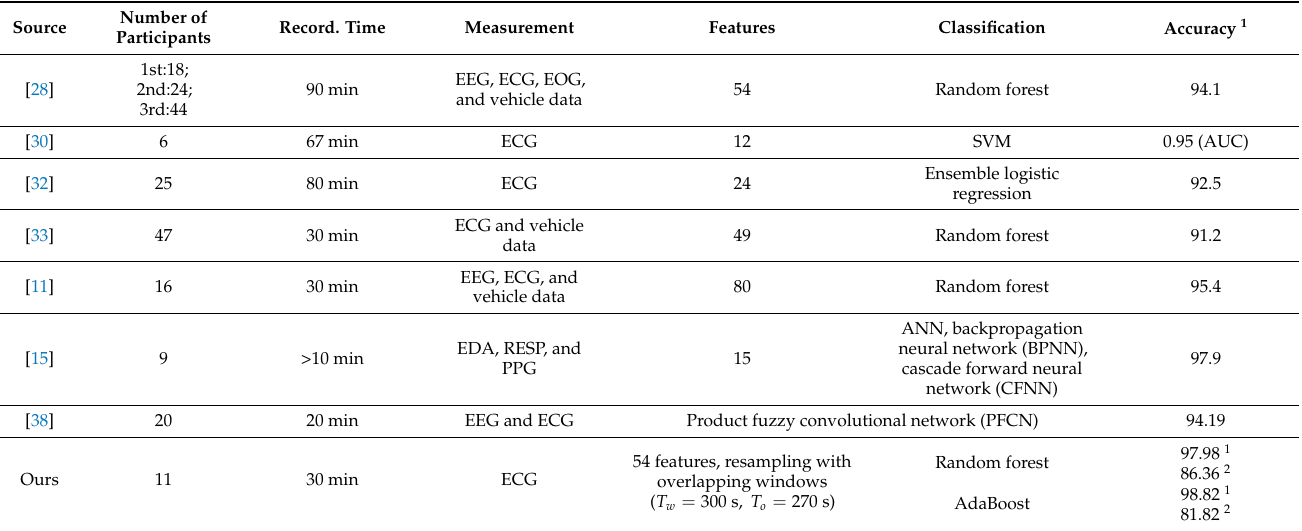
Table 10. Comparison of the proposed driving fatigue detection framework with previous driving fatigue detection